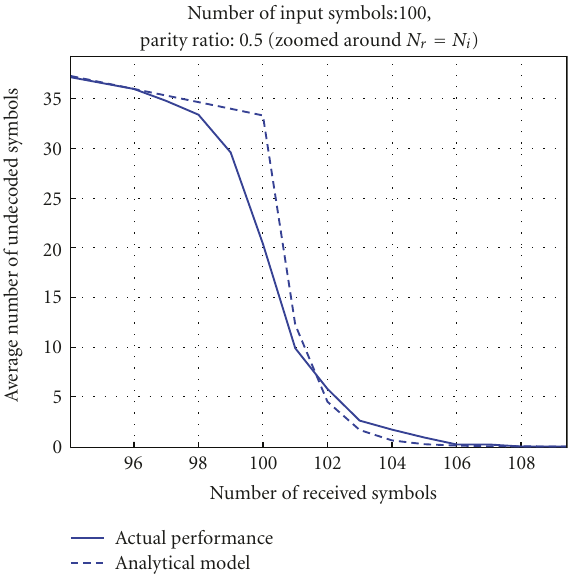
Figure 12: Performance curve of Raptor coding (zoomed around N r = N i ), N i = 100, ρ = 0 . 5